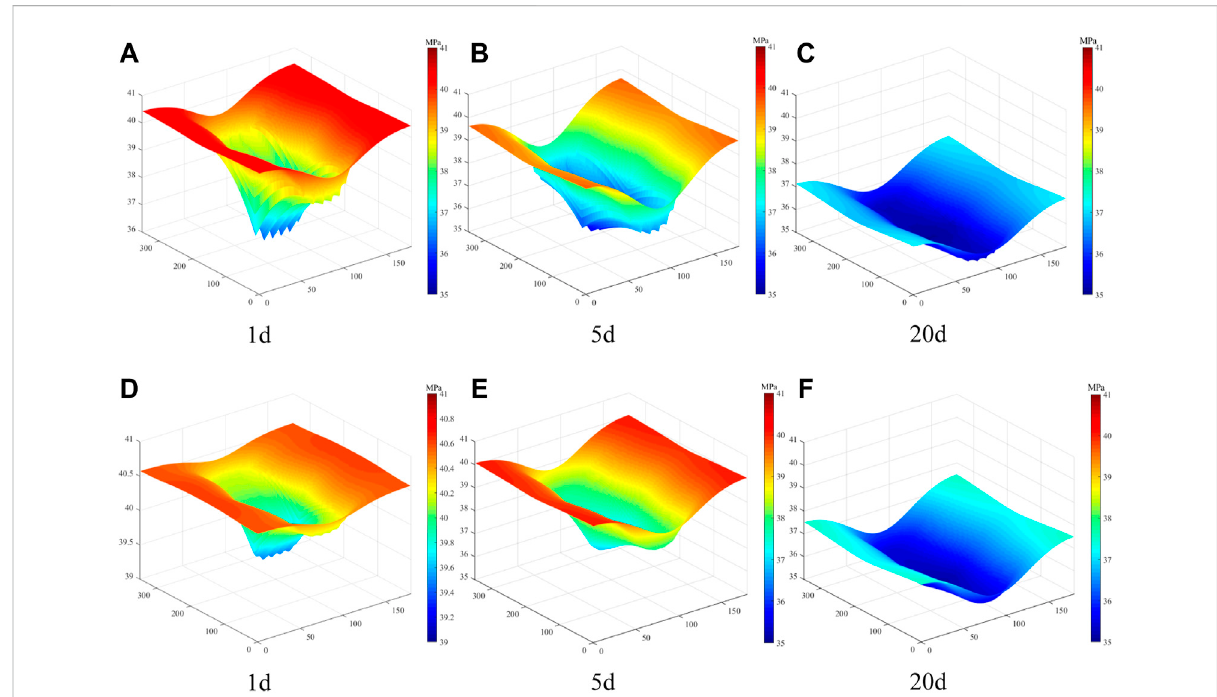
FIGURE 12 Distributionofpressureinmicro-fracturesystemandmatrixduringproductionperiod.(In (A – C) ,therangepressureinmicro-fracturesystemis from 35 to 41 MPa. In (D) , the range of pressure in matrix is 39 – 41 MPa. In (E,F) , the range of pressure in matrix is from 35 to 41